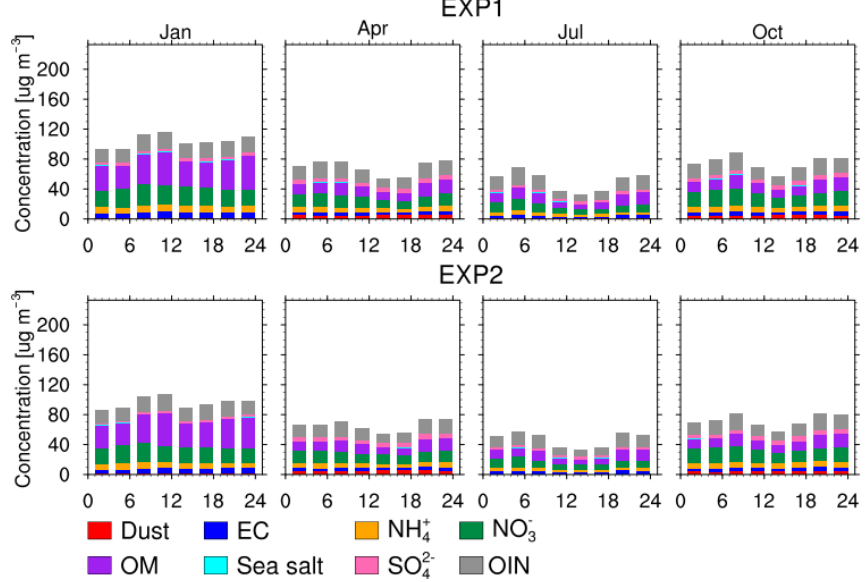
Figure 9. Diurnal cycle of surface PM 2 . 5 composition concentrations (dust, OM, EC, sea salt, NH + averaged over Hefei for January, April, July, and October of 2018 from experiments EXP1 and EXP2.